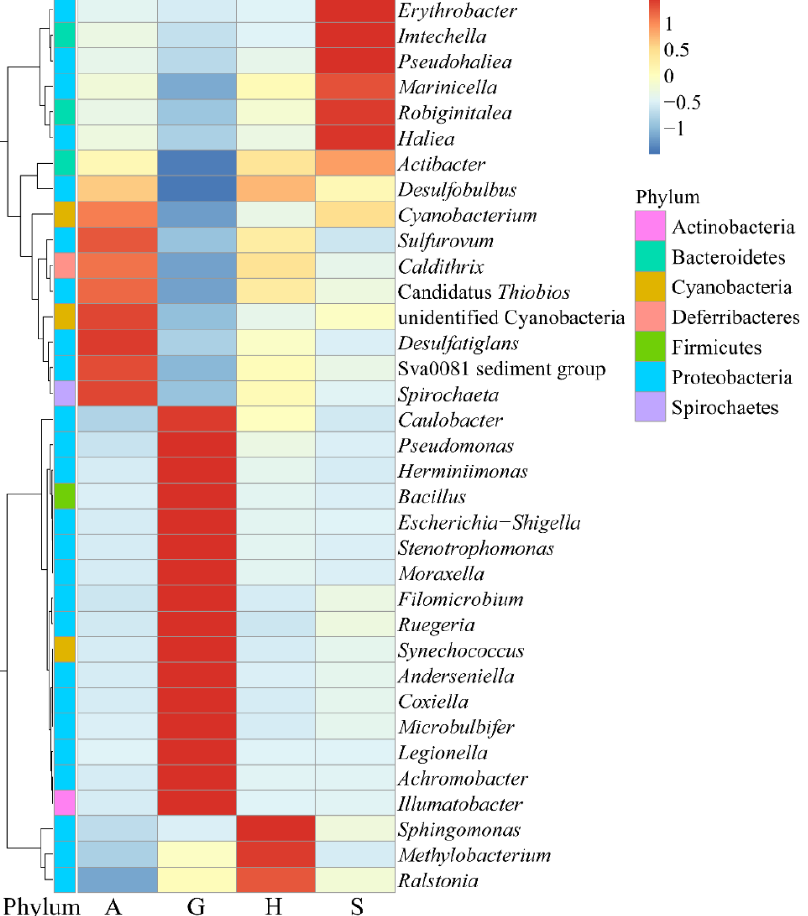
Figure 4. Heat map of the relative abundance of the 35 most abundant microbial genera in the worm intestine and different sediments. S — surface sediment; H — sediment in the hole; A — ambient sediment; G — gut of S. nudus .